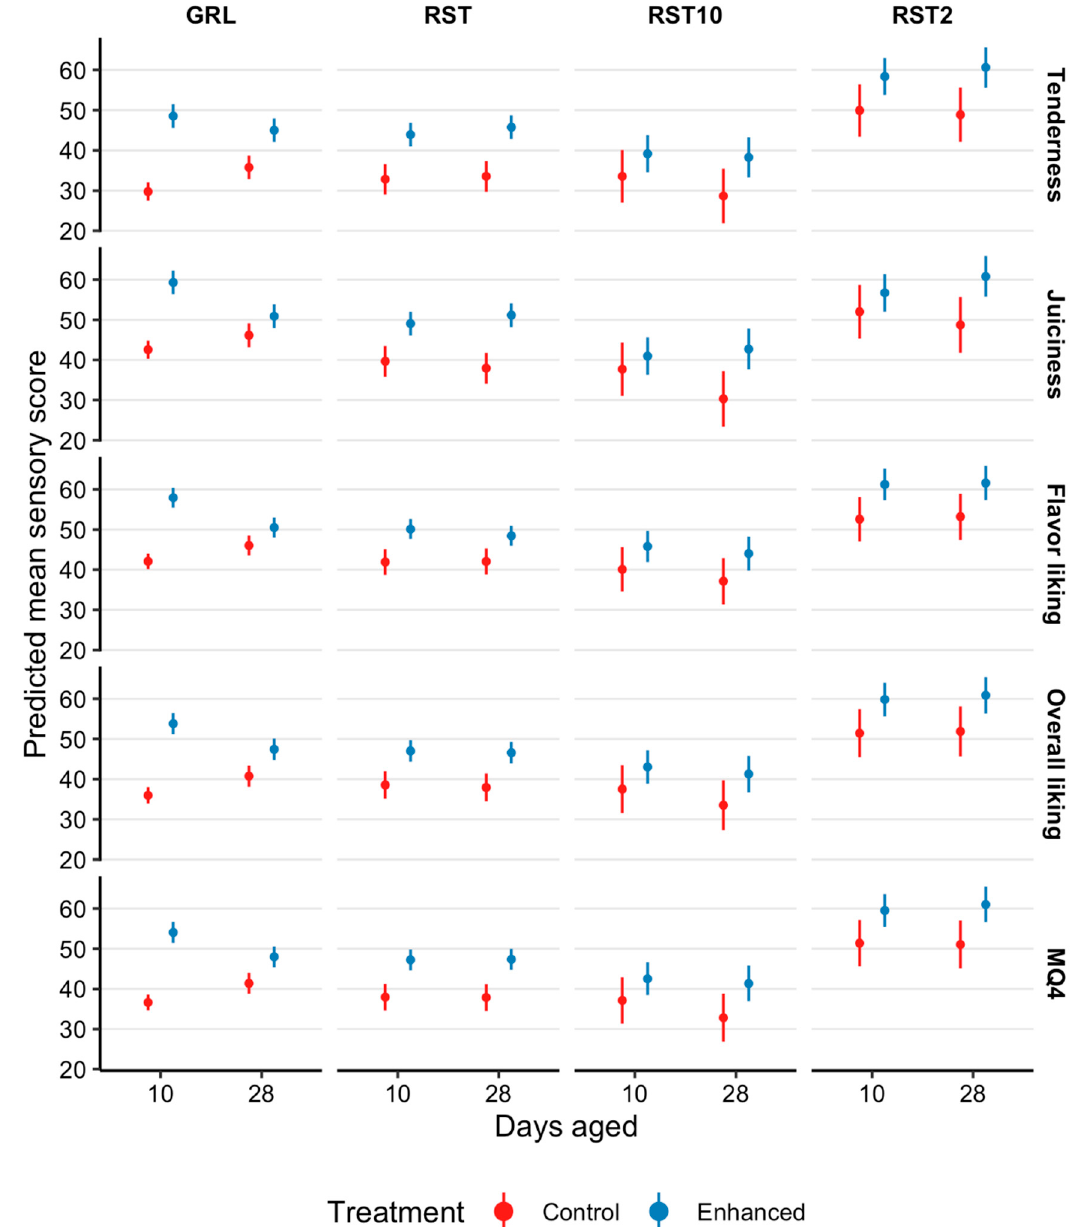
Figure 3. Estimated marginal means with 95% confidence intervals for tenderness, juiciness, flavor liking, overall liking, and eating quality (MQ4) scores of outside flats (OUT005, M. biceps femoris ) presented to consumers ( n = 2080) as grill (GRL), 10 mm hot roast (RST), 2 mm cold roast (RST 2 ) and 10 mm cold roast (RST 10 ) that were not infused (control) and infused with a kiwifruit extract (enhanced), and aged for 10 or 28 days.